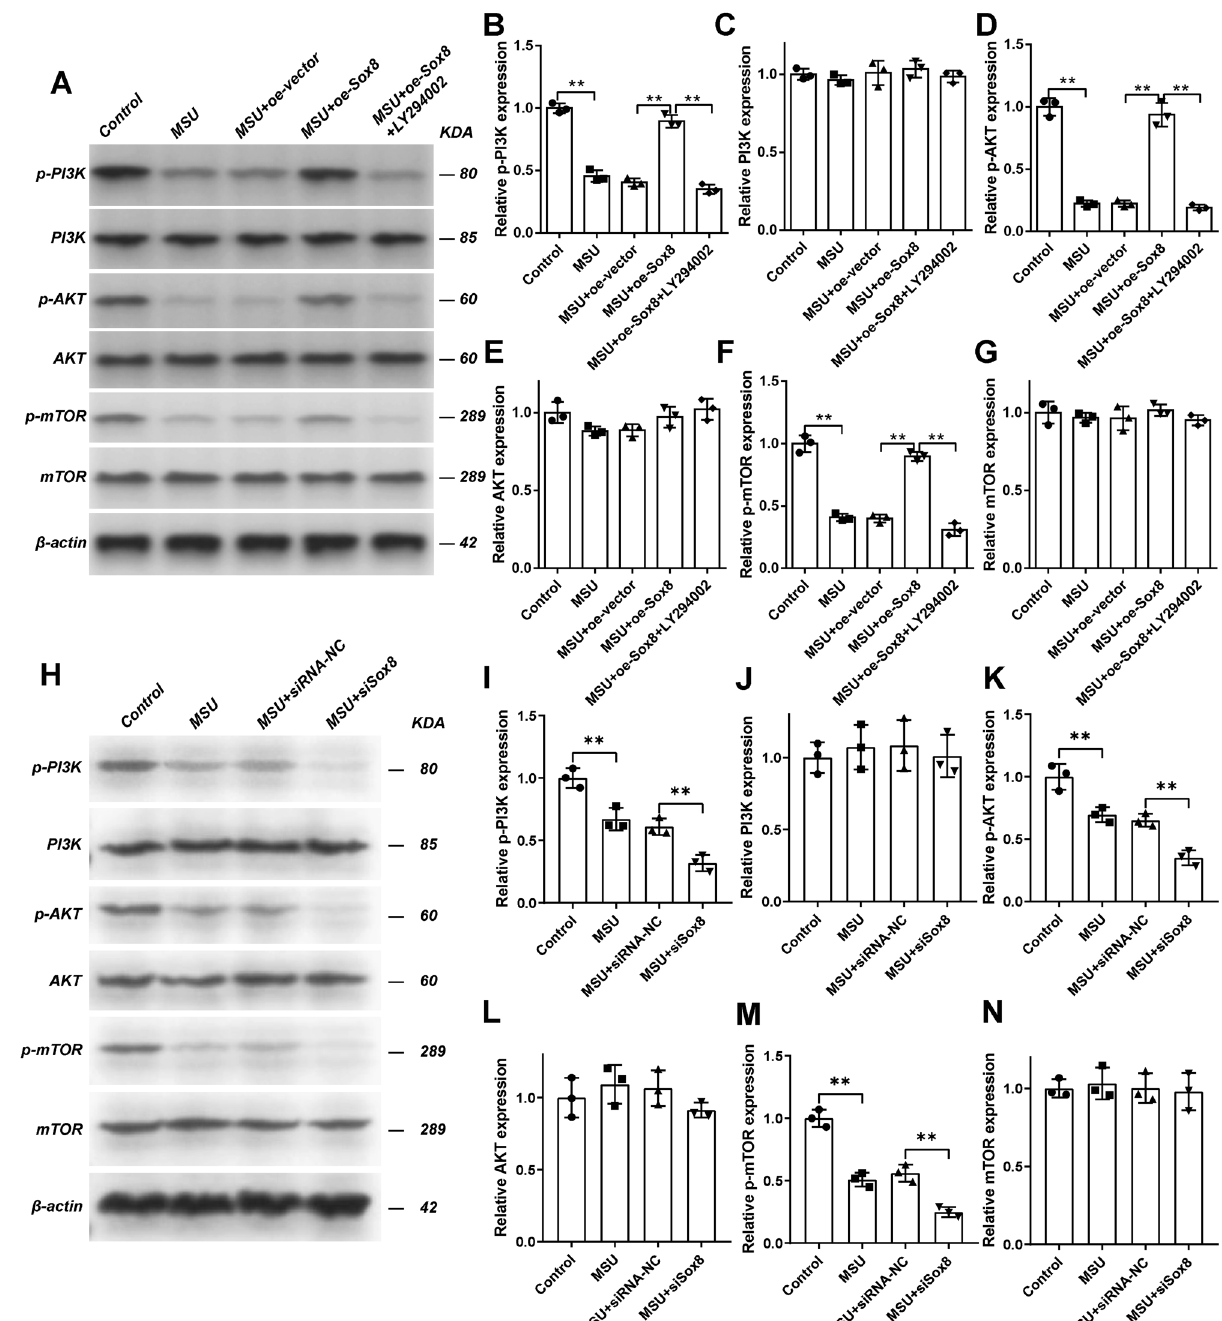
Fig. 7 Sox8 mediated the effects of MSU on the PI3K/AKT/mTOR signaling pathway. Overexpression of Sox8 rescued the effects of MSU on the PI3K/AKT/mTOR signaling pathway. The C28/I2 cells were transfected with oe-vector or oe-Sox8 by lentiviral vector, treated with MSU (200 μ g/mL) for 24 h, and stimulated with LY294002 (10 μ M) for 1 h. The expression levels of p-PI3K ( A , B ), PI3K ( A , C ), p-AKT ( A , D ), AKT ( A , E ), p-mTOR ( A , F ), and mTOR ( A , G ) from the indicated groups were detected by western blot assay. Sox8 knockdown inhibited PI3K/AKT/mTOR signaling pathway. The C28/I2 cells were transfected with siRNA-NC or siSox8, then they were treated with MSU (200 μ g/ml) for 24 h. The expression of p-PI3K ( H , I ), PI3K ( H , J ), p-AKT ( H , K ), AKT ( H , L ), p-mTOR ( H , M ), mTOR ( H , N ) from the indicated group were detected by western blot assay. Results are the mean ± SD for three individual experiments. * P < 0.05, ** P < 0.01.